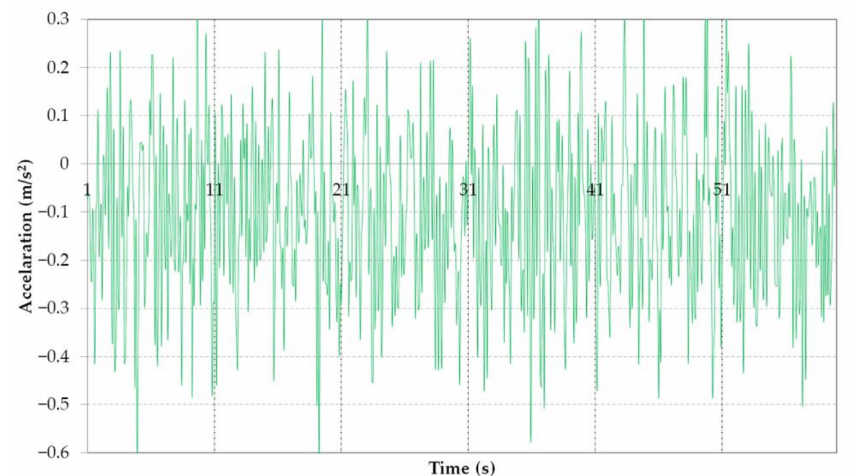
Figure 20. Sample of measured acceleration in vertical plane (direction Y